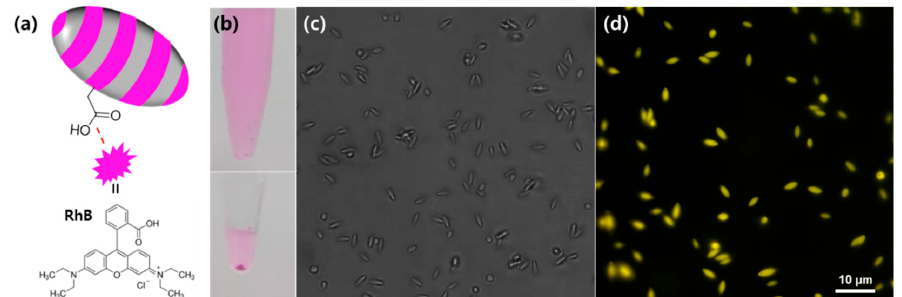
Figure 5. ( a ) Schematic showing the complexation of rhodamine B dye on the acid-functional surface of MPA-modified PS 34k - b -PB 25k particles ( d pore = 2.1 μ m); ( b ) photograph of the dye-complexed particle before the (upper) and after the (bottom) centrifugation; ( c ) optical microscope; and ( d ) the fluorescent microscopic image of rhodamine B functionalized ellipsoidal particles.